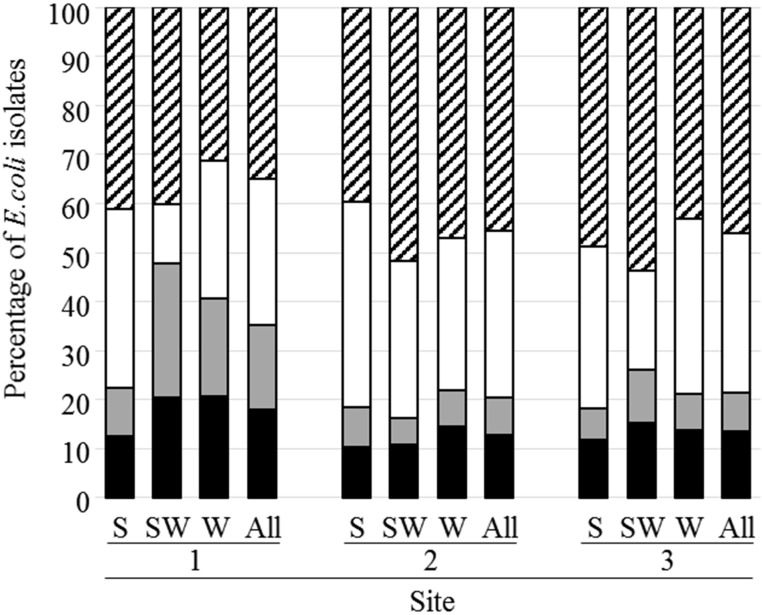
Distribution of E. coli isolates according to their phylogenetic group. The phylogenetic groups A, B1, B2, and D are represented by hatched, white, gray and black bars, respectively. S, shellfish; SW, seawater; W, river or brackish water.